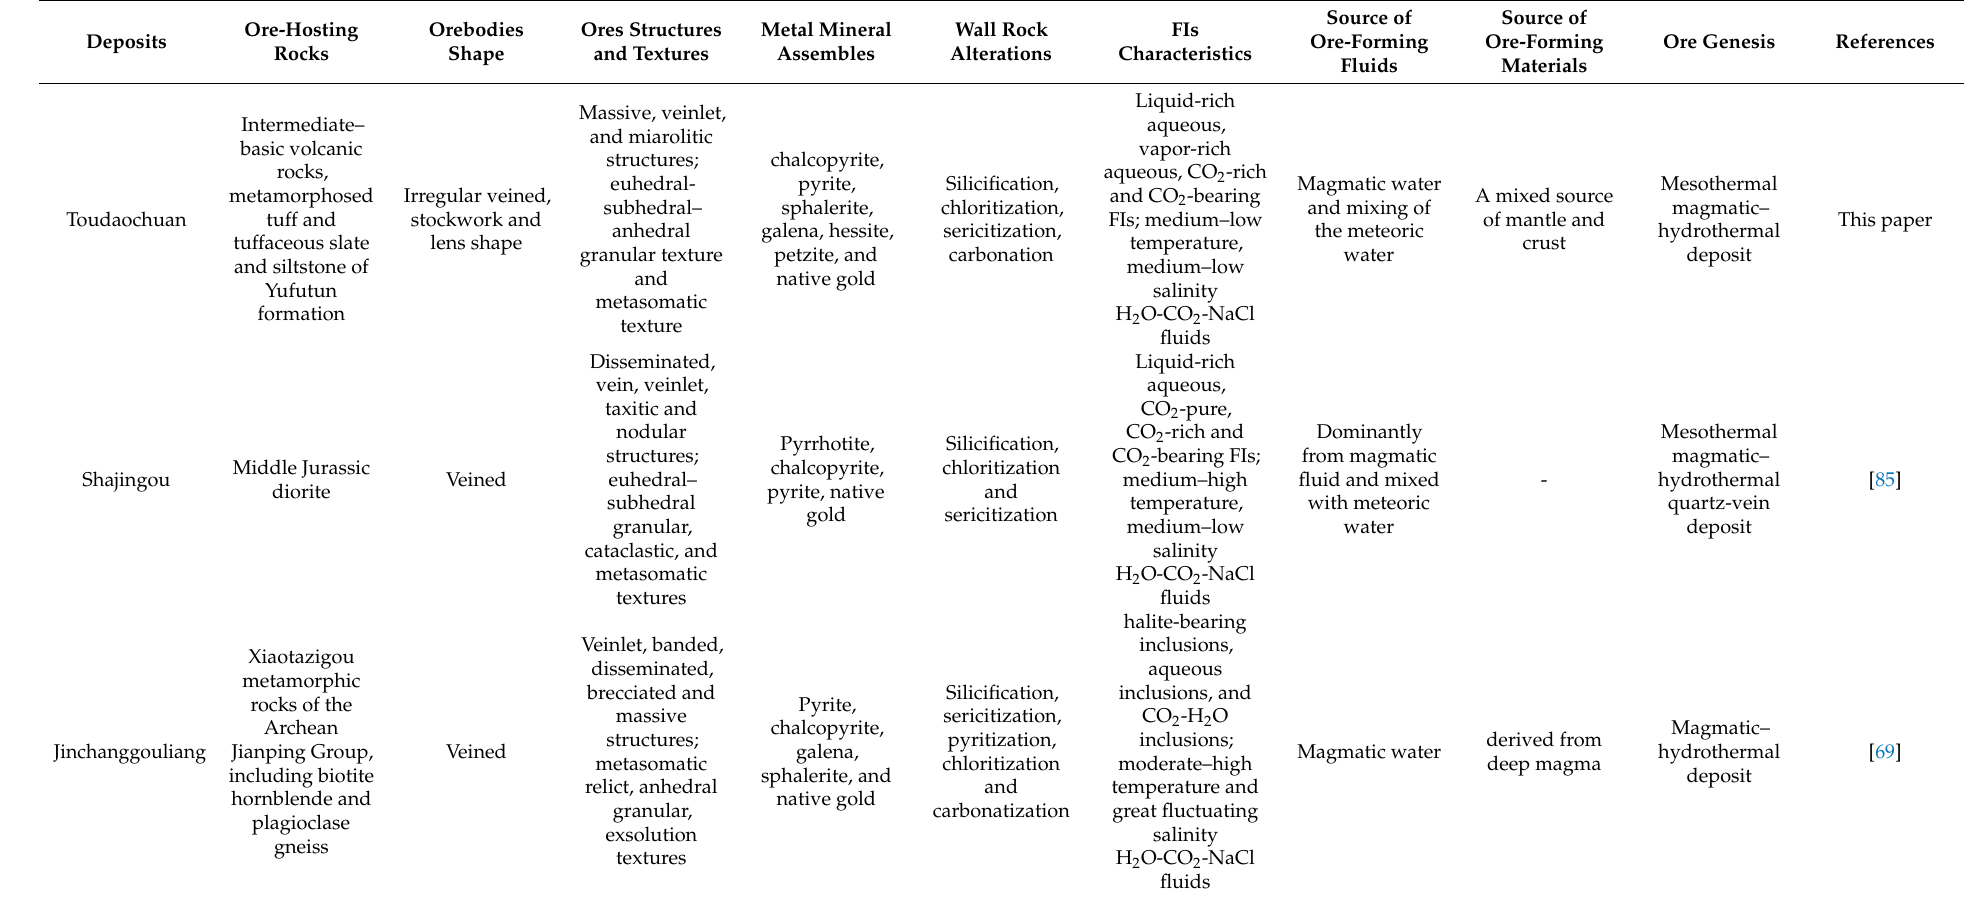
Table 4. Comparison between the Toudaochuan Au deposit and typical mesothermal magmatic–hydrothermal gold